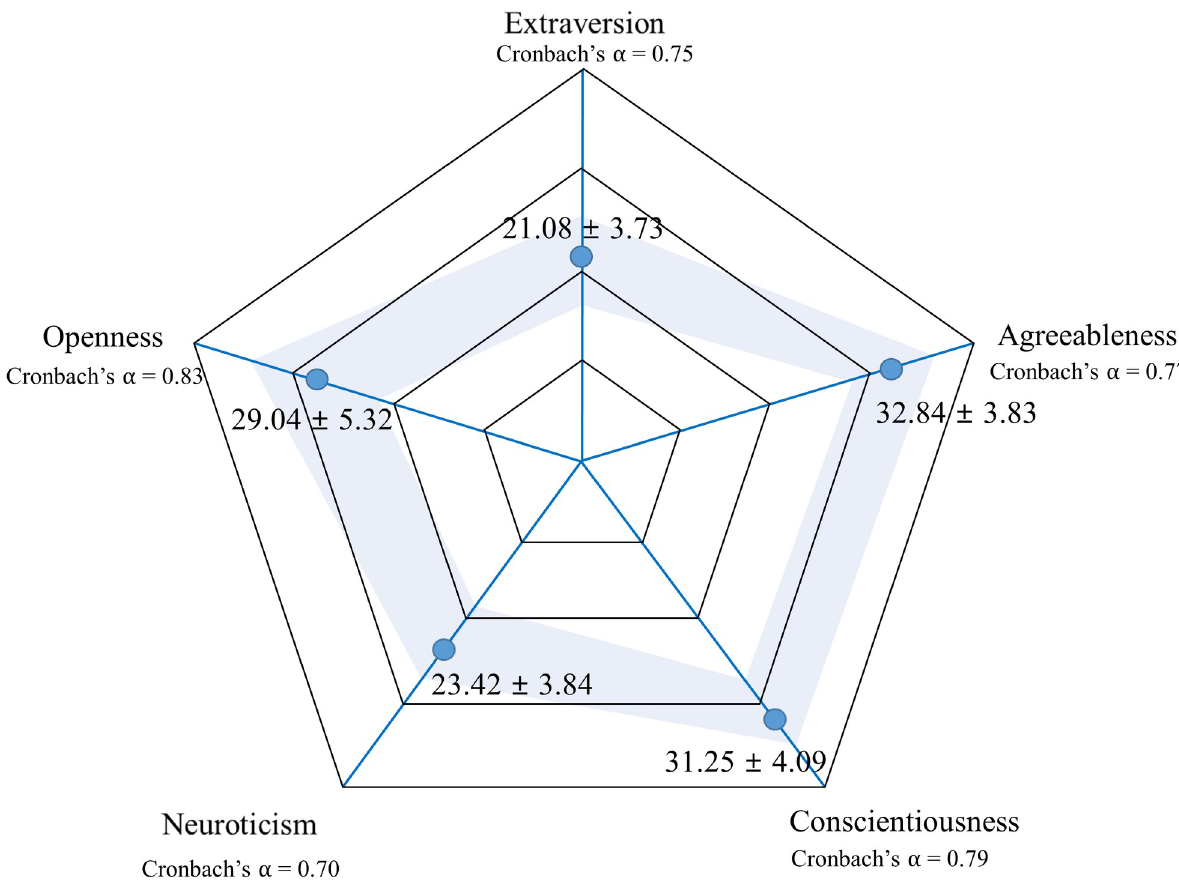
Fig 2. Score distribution according to the personality traits of participants. Score distribution is expressed as mean and standard deviation.